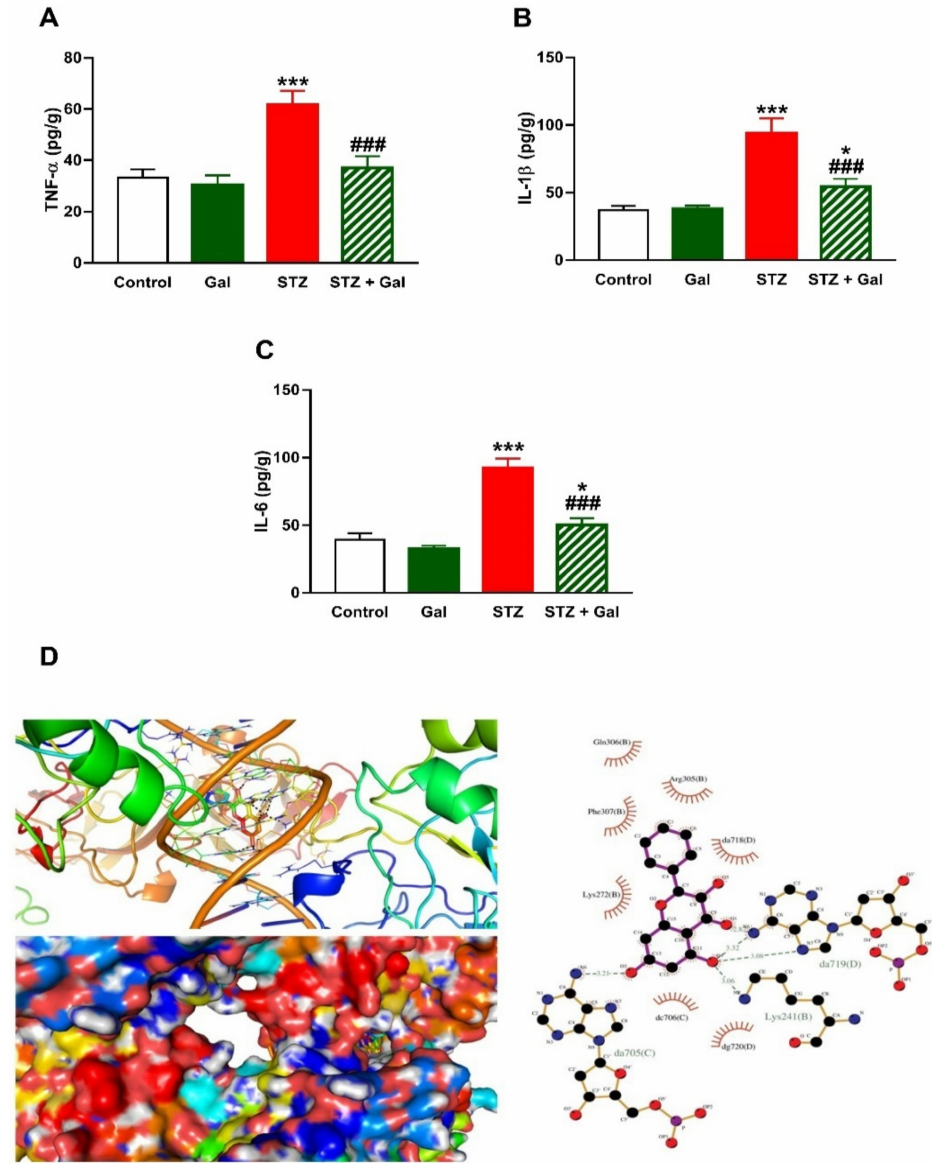
Figure 7. Galangin mitigates hepatic inflammation in diabetic rats. Galangin decreased hepatic TNF- α ( A ) IL-1 β ( B ), and IL-6 ( C ) in diabetic rats. Data are mean ± SEM, n = 6. * p < 0.05 and *** p < 0.001 versus control. ### p < 0.001 versus diabetic. ( D ) Molecular docking analysis